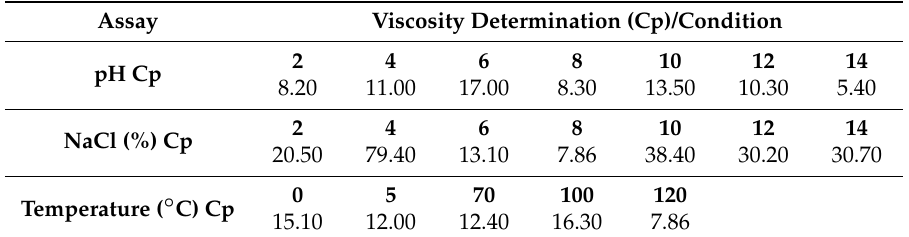
Table 5. The characteristics and properties of the bioemulsifier produced by Bacillus subtilis UCP 0146. Assay